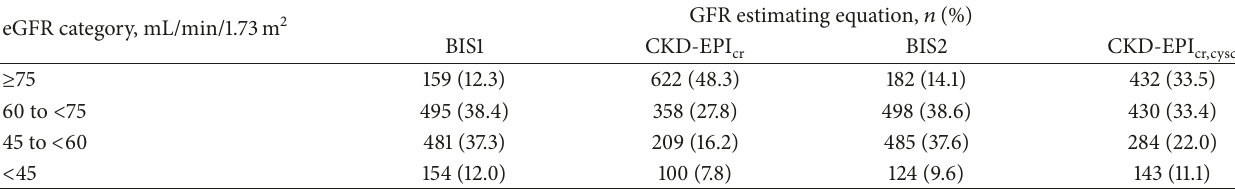
Table 1: Prevalence of eGFR category using 4 different estimating